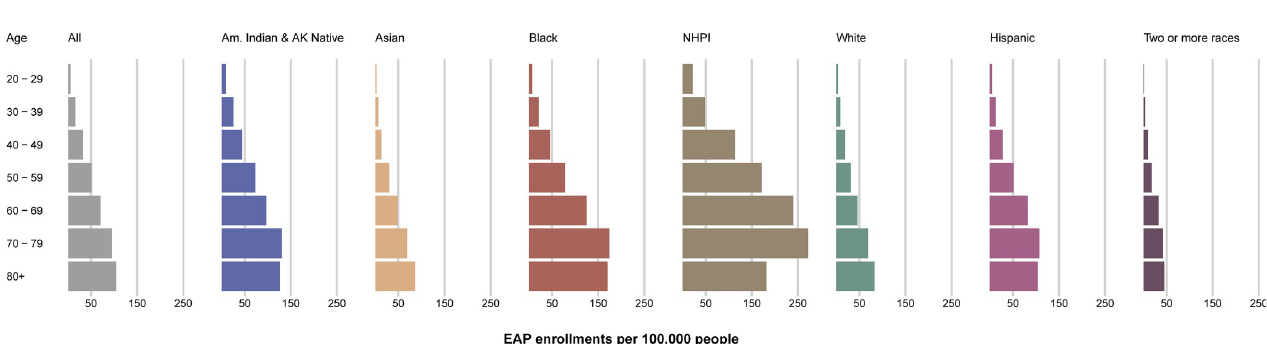
Fig 3. Patient enrollment in the US Expanded Access Program (EAP) stratified by age, race, and ethnicity group, per 100,000 people (from the US census). AU : PleasecheckthattheeditstothetitleofFig 3 captureyourmeaning : Ifnot ; pleaseprovidecorrectwording : The length of each colored bar is proportional to the number of patients enrolled in the US EAP within the identified age group (years) and race or ethnicity category. The patient enrollment values are presented relative to analogous categorical data retrieved from the US Census Bureau. Am. Indian & AK Native, American Indian or Alaska Native; NHPI, Native Hawaiian or Other Pacific Islander.